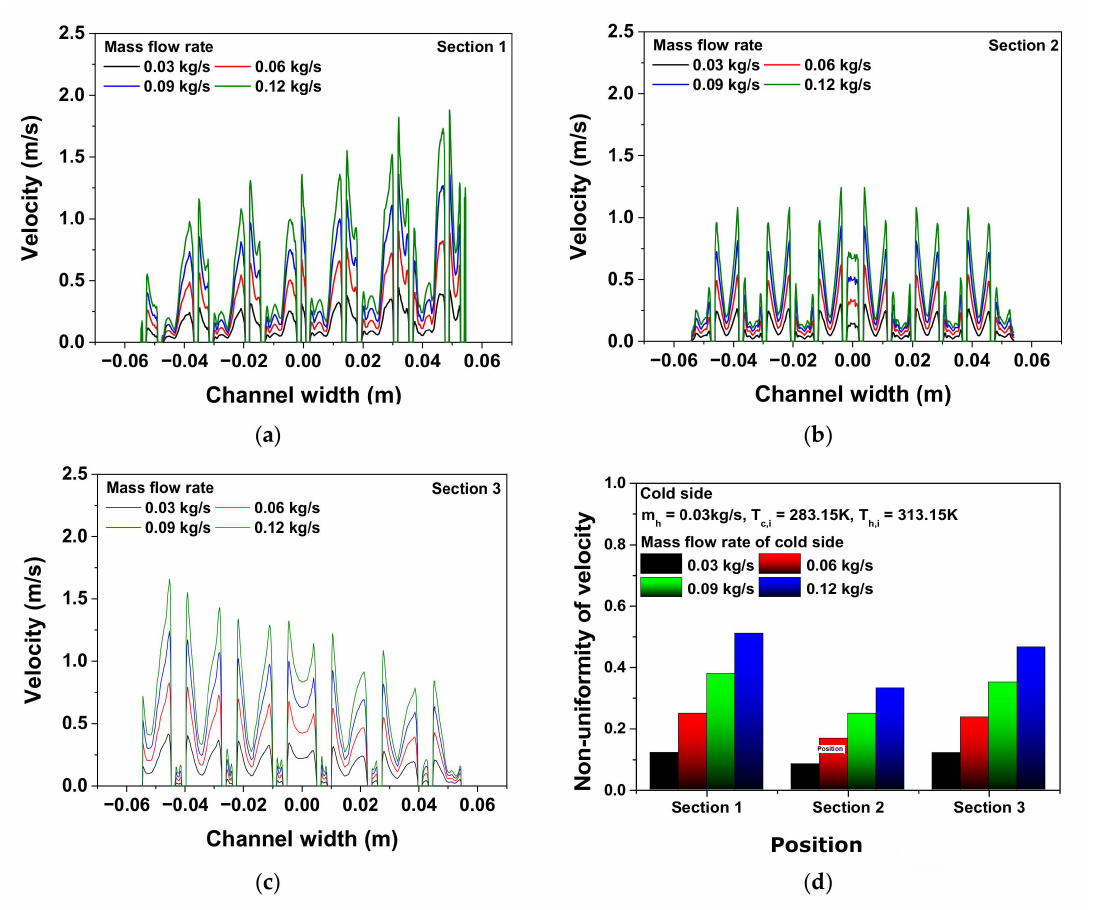
Figure 7. Velocity and cold side at each position: ( a ) Section 1, ( b ) Section 2, ( c ) Section 3, and ( d ) non-uniformity of